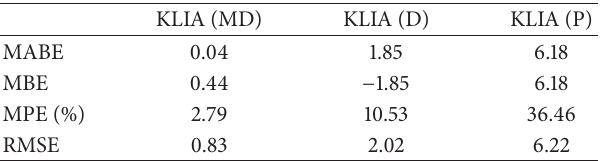
Table 2: Errors obtained from 3 methods for KLIA